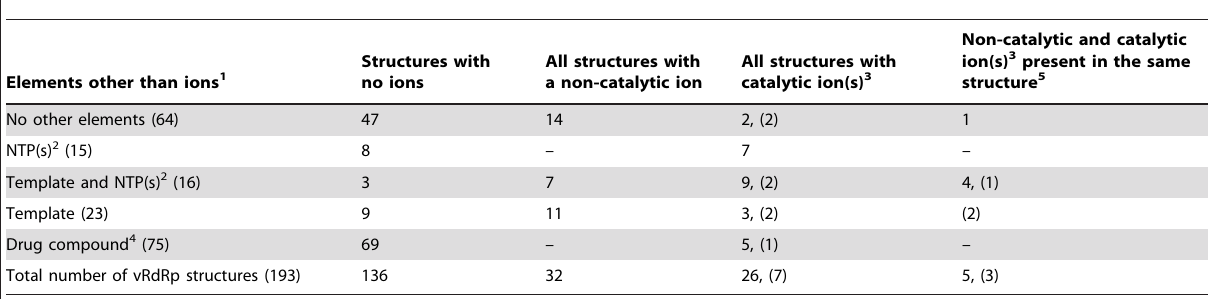
Table 1. Number of vRdRp structures with ions or other elements proximal to the catalytic